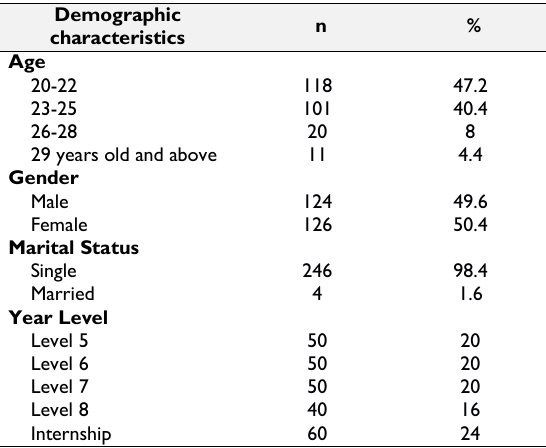
Table 1 Demographic characteristics of the participants (N =